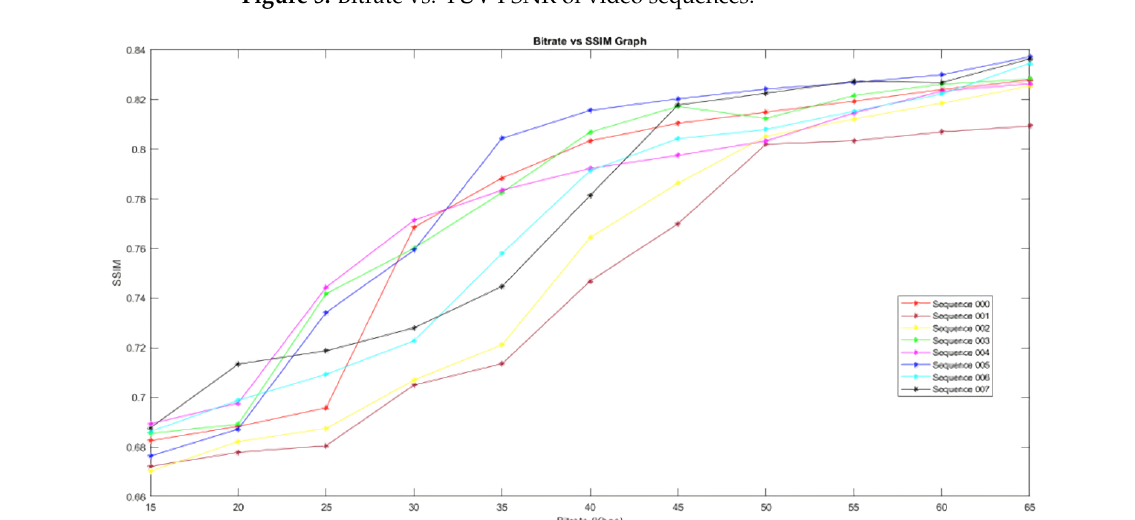
Figure 6. Bitrate vs. SSIM of video